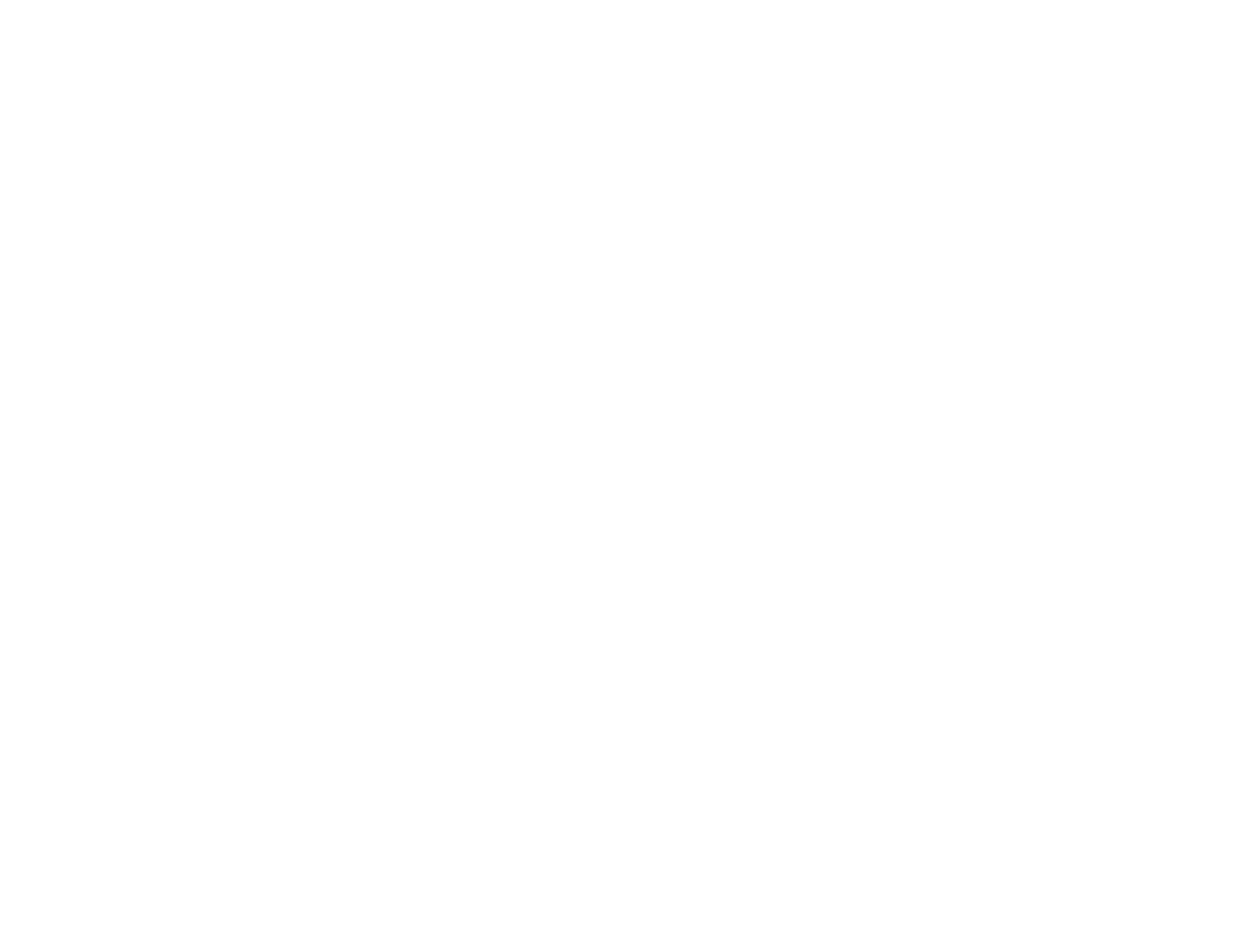
are identified at the class-level (purple = Gamma-proteobacteria; gold = class Chloroflexi; yellow = Clostridia, light-blue = Nitrospira; green = Acidobacteria; maroon = Betaproteobacteria; dark-blue =